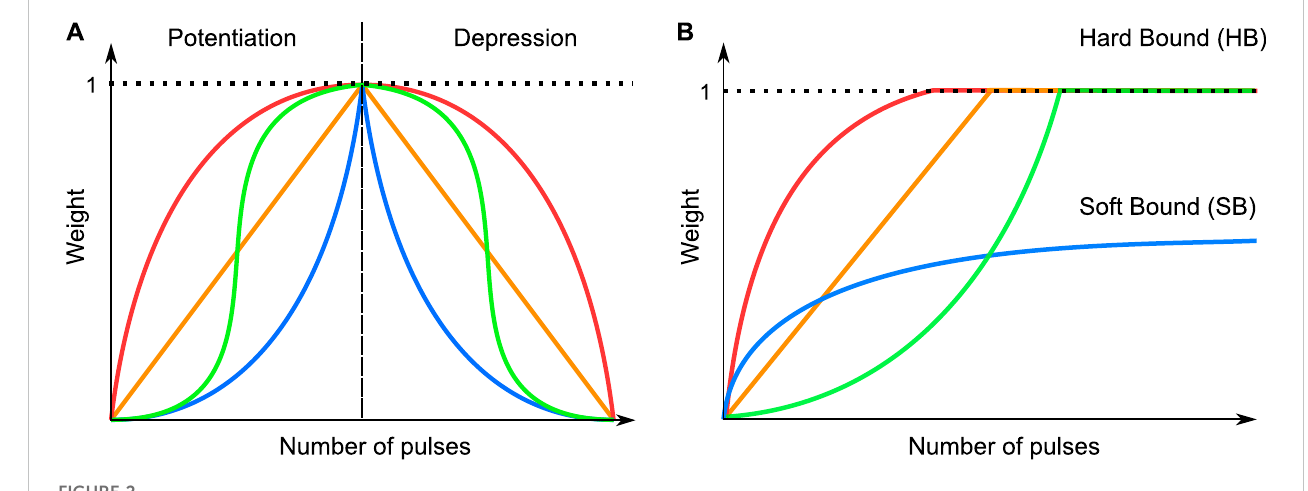
FIGURE 2 Schematic depiction of different types of synapse behavior (A) and different bounding behaviors (B)